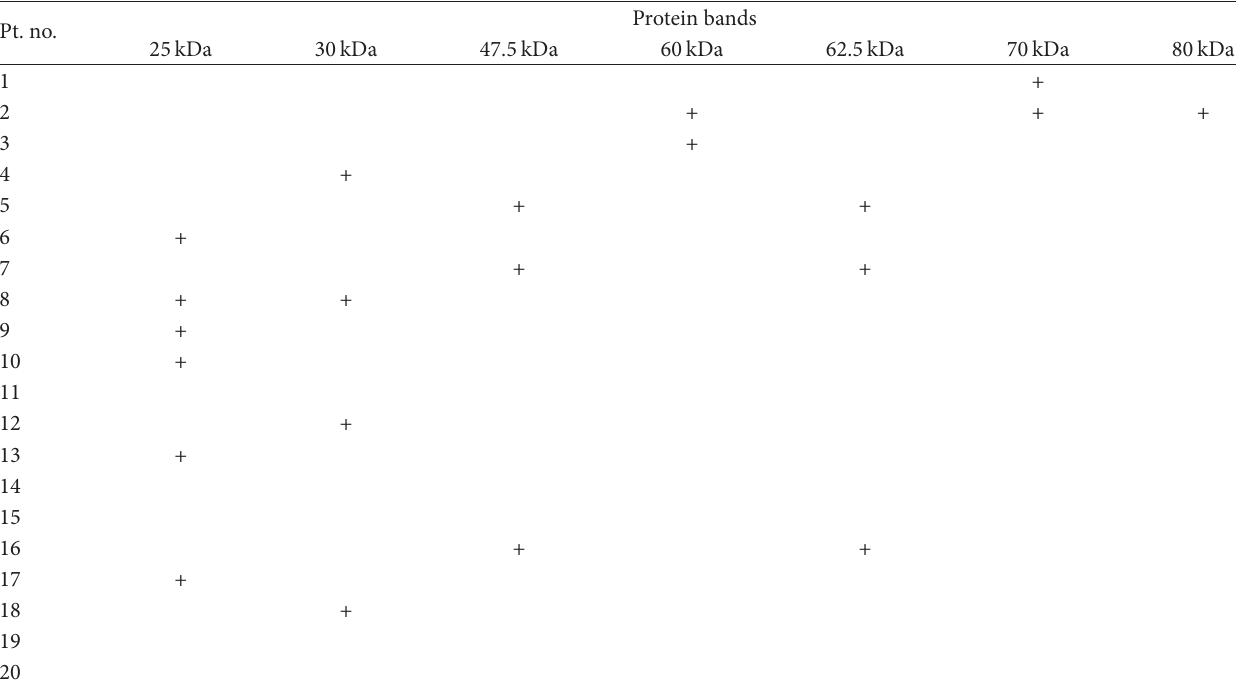
T 2: Protein bands reactive with BM supernatant samples from IRP patients. Pt.